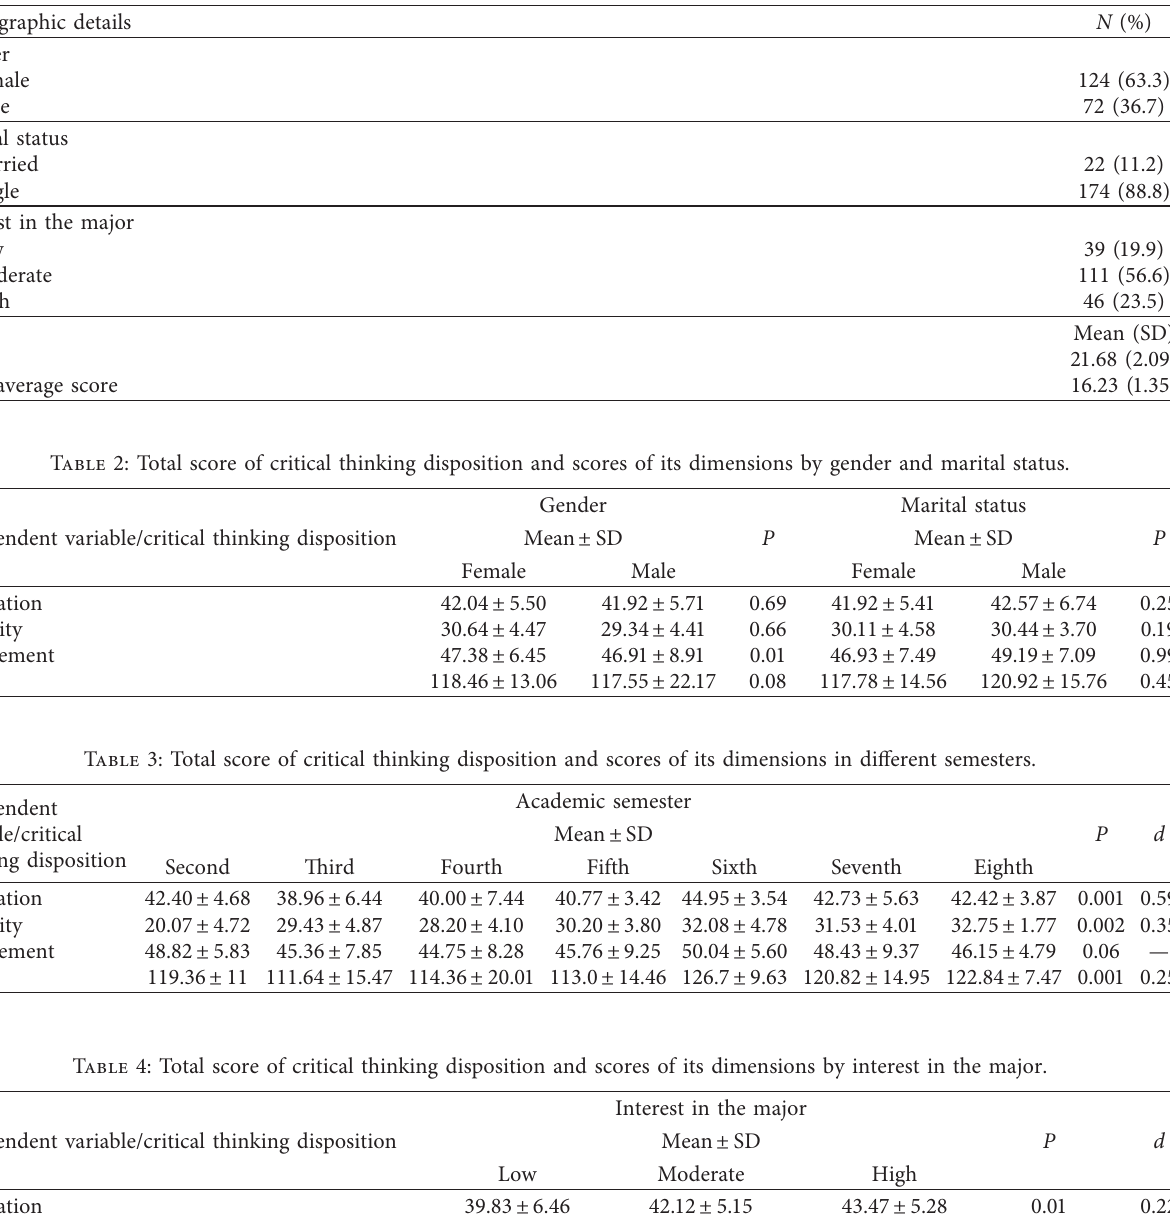
Table 1: Demographic details of the study subjects.